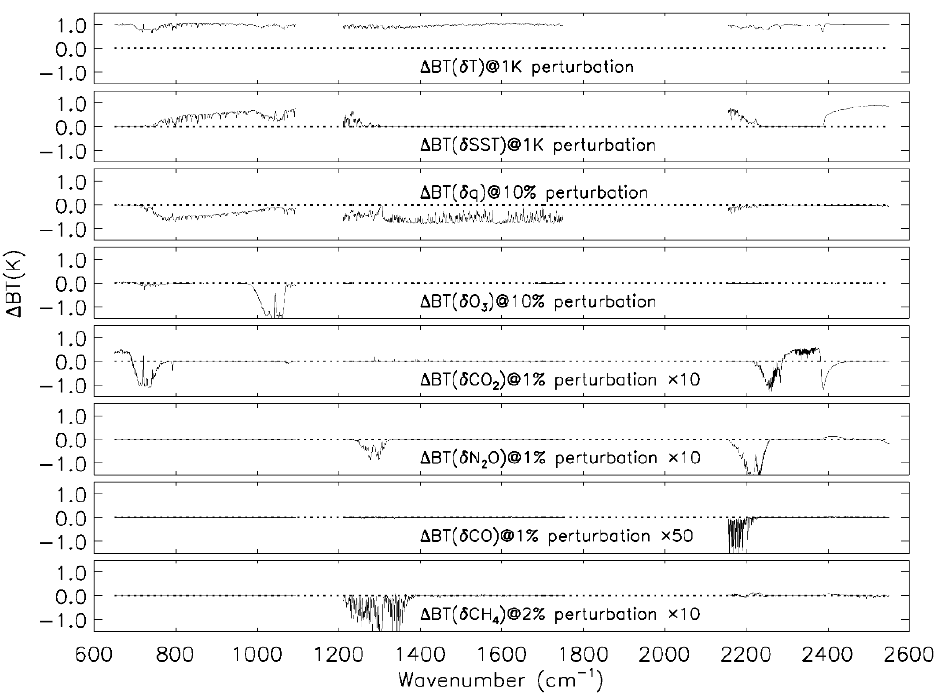
Figure 1. Information content from CrIS observation: brightness temperature impact due to the change in atmospheric temperature (T), the sea surface temperature (SST), water vapor (q) (H 2 O), ozone (O 3 ), carbon dioxide (CO 2 ), nitrous oxide (N 2 O), carbon monoxide (CO), and methane (CH 4 ) in CrIS channels.